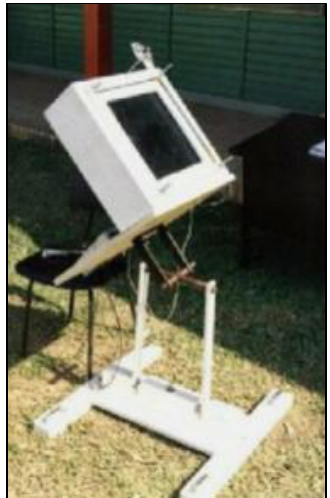
Figure 28. Front View of Fenestration Radiometer Prototype [38].